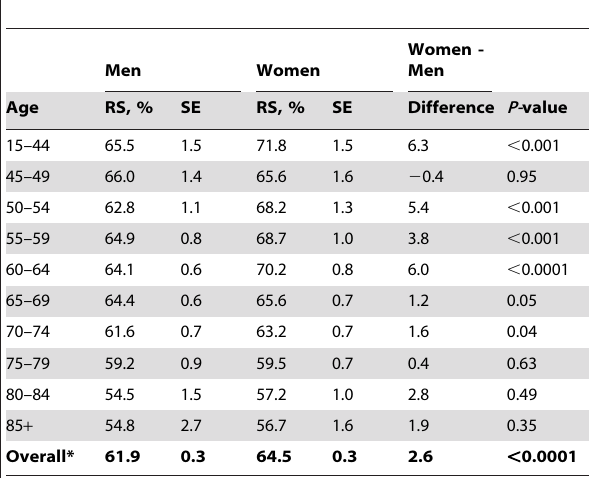
Table 2. Age-specific 5-year relative survival of colorectal cancer patients in period 2002–2006 by sex.